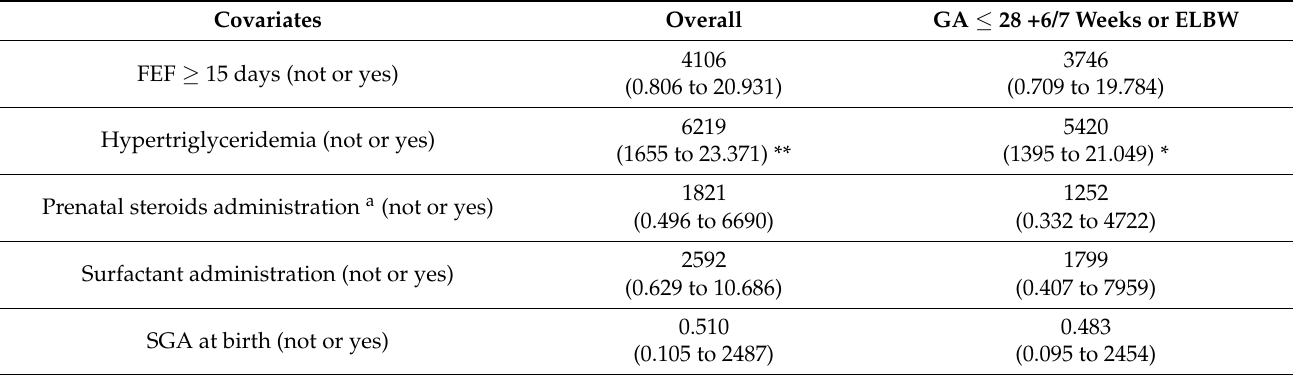
Table 3. Binary logistic regression analysis evaluating the influences of covariates on prolonged invasive mechanical ventilation (more than 7